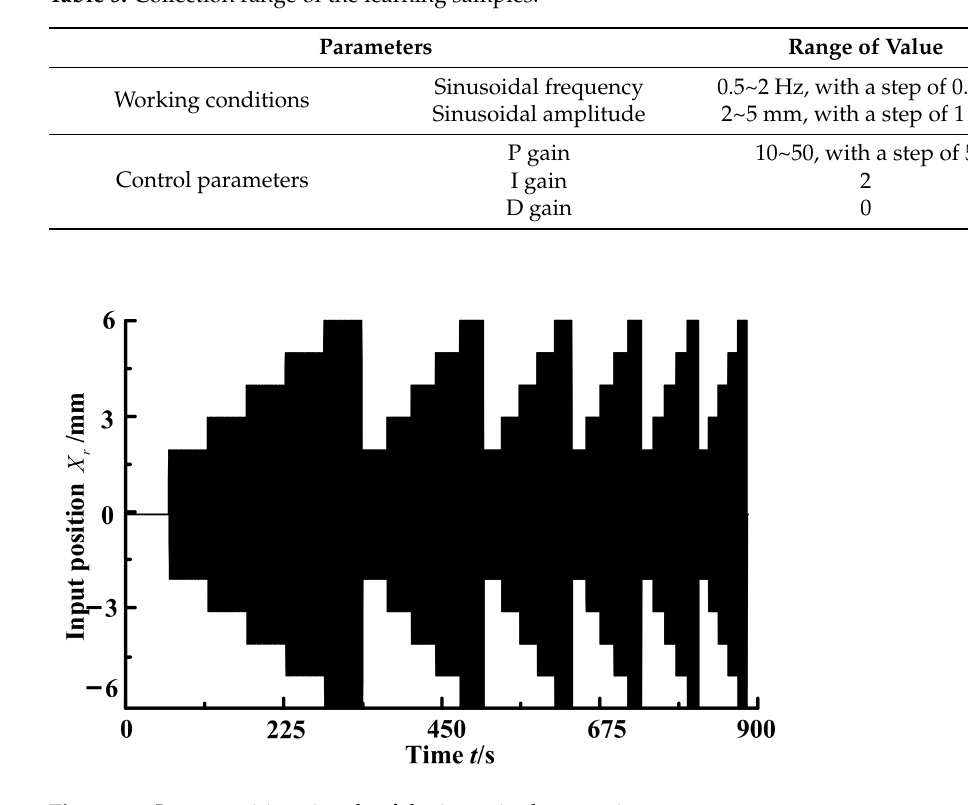
Figure 14. Input position signals of the input in the